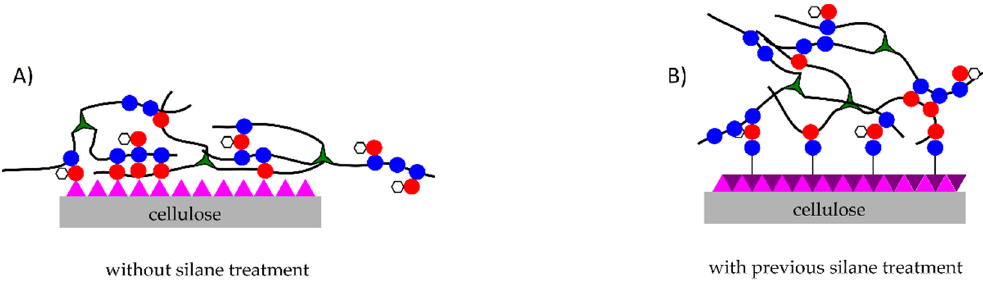
Figure 11. Potential chemical reactions that take place during manufacturing ELO-based composites ( A ) without previous silane treatment and ( B ) with a previous silanization surface treatment.